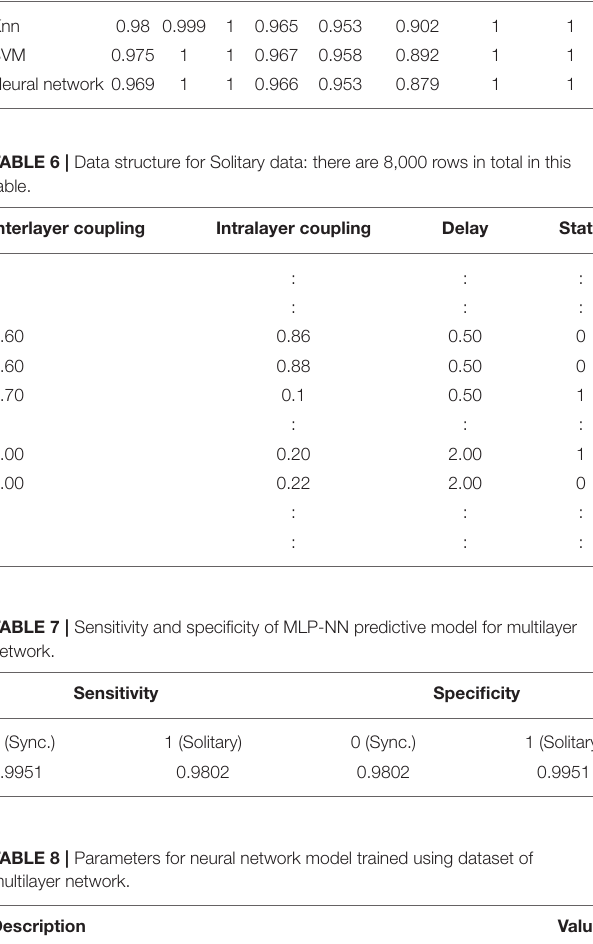
TABLE 5 | Specificity of different algorithms for 2D lattice network. Algorithm